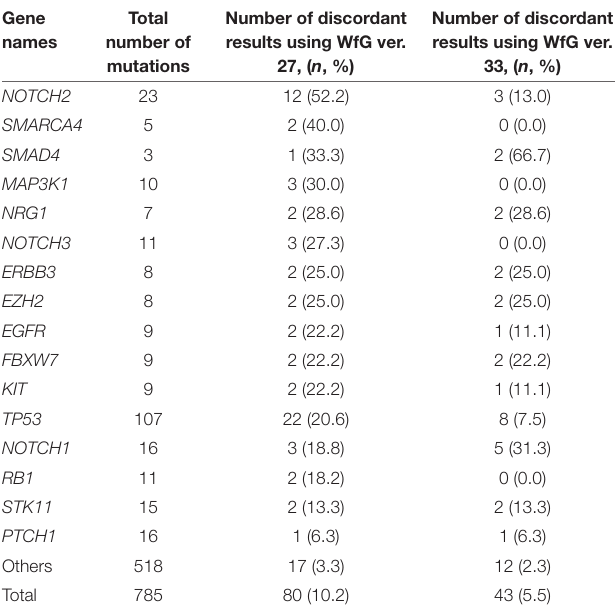
TABLE 2 | The number and the proportion of unmatched mutations between the expert panel and WfG (in genes with ≥ 2 pathogenic mutations detected by both